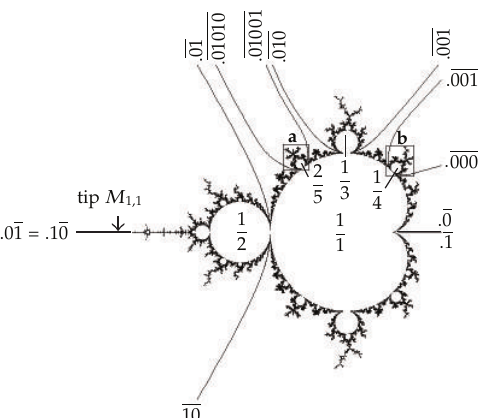
Figure 4: Mandelbrot set with some representative external arguments. Shrub (cid:5) 2 / 5 (cid:6) and shrub (cid:5) 1 / 4 (cid:6) are framed in rectangles a and b